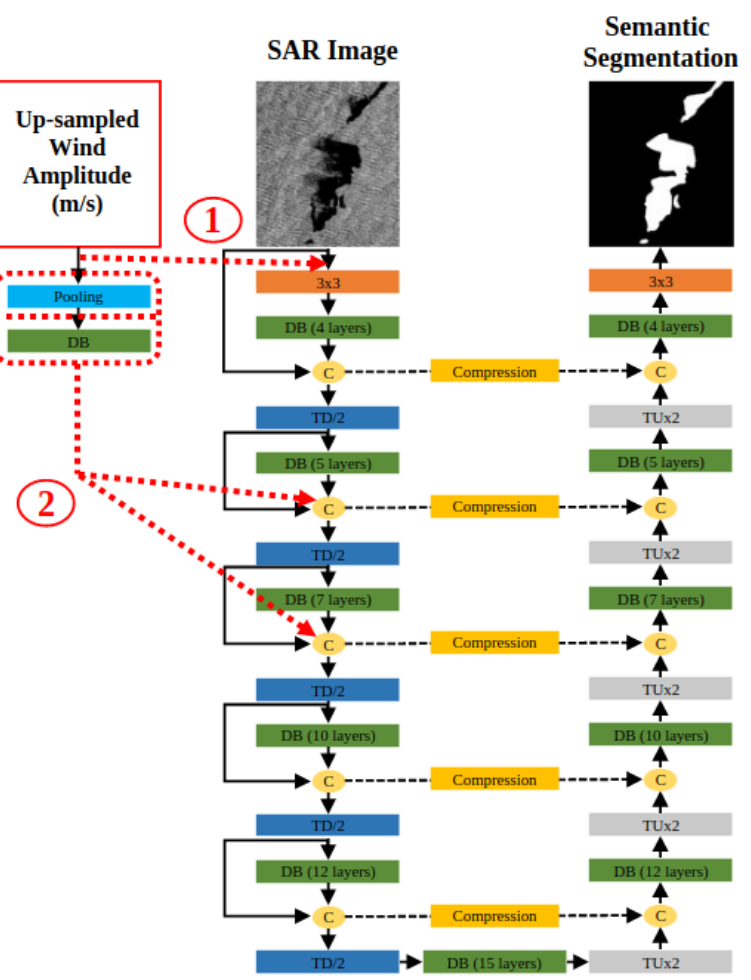
Figure 5. Fuse-FC-DenseNet architectures that fuse heterogeneous data, wind, and SAR information. The left branch is the wind branch, and the operations surrounded by red dotted lines are the different ways to fuse the wind speed information with the SAR information. (1) represents the early fusion, (2) represents the late fusion. The operations surrounded by red dotted lines are selected depending on the